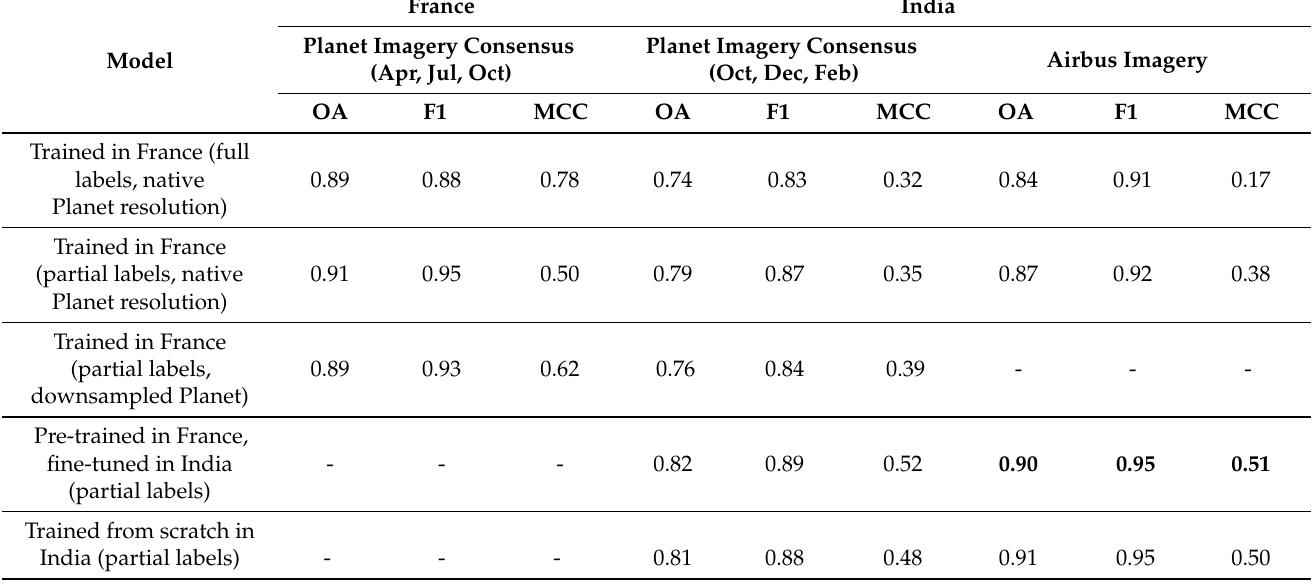
Table 3. Pixel-level assessment of field delineation in France and India. Table columns show results using a 3-month Planet image consensus in France and results using both the Planet consensus and Airbus imagery in India. Each row varies the amount of knowledge transfer from France and degree of additional training in India. The reported metrics are overall accuracy (OA), F1-score (F1) and Matthews correlation coefficient (MCC). The performance of the best model is highlighted in